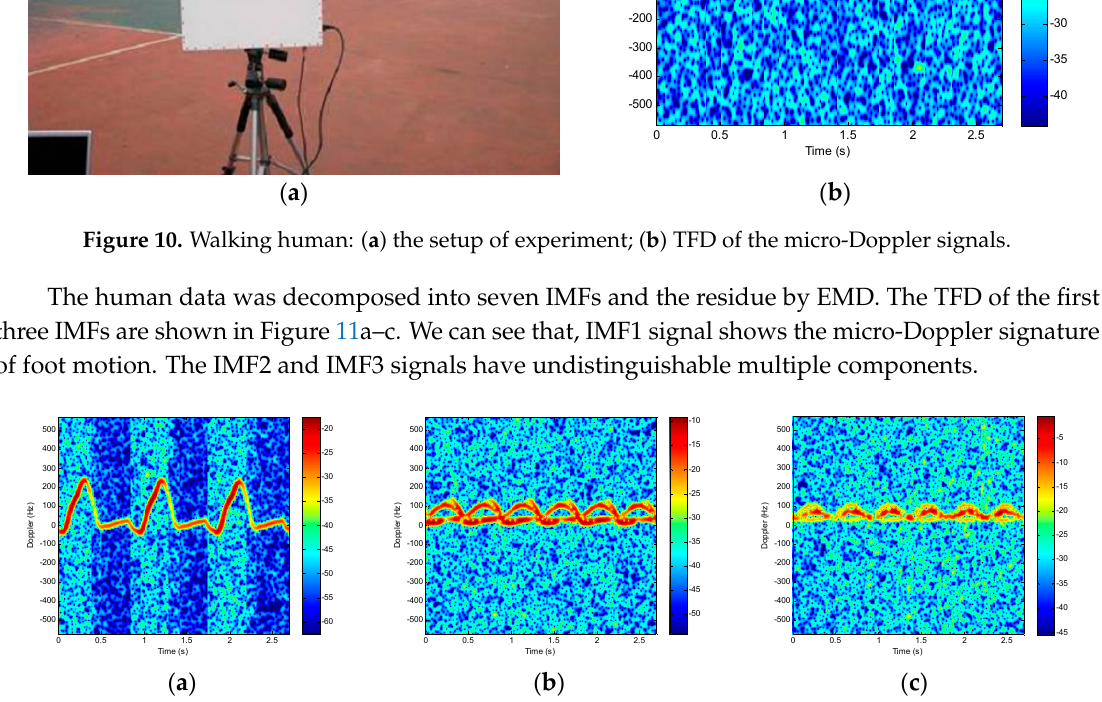
( b ) Figure 12. Decomposition results of IMF2 signals: ( a ) TFD of AMD1; ( b ) TFD of AMD2. Time (s) D opp l e r ( H z ) 0 ( c ) Figure 13. Decomposition results of IMF3 signals: ( a ) TFD of AMD1; ( b ) TFD of AMD2; ( c ) TFD of AMD3. 6. Conclusions The method for decomposing multicomponent micro-Doppler signals based on AMD-HHT is proposed in this paper. This method solves the problem that Hilbert-Huang transform cannot identify and separate the signal with close-frequency components. The process is as follows. Firstly, the signal is decomposed by EMD, and Hilbert-Huang spectrum and marginal spectrum are obtained by Hilbert transform. If there is frequency aliasing in the decomposed signal, the close-frequency components are separated by AMD. A set of simulations and the experimental testing on radar echo are used to assist in the interpretation of the method analytically. By